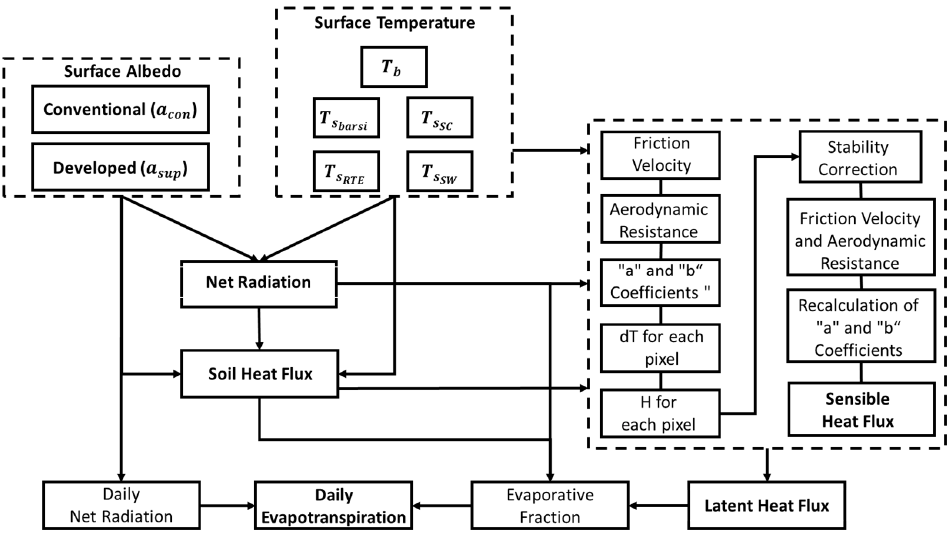
Figure 3. Flowchart of the processing steps of the SEBAL algorithm.